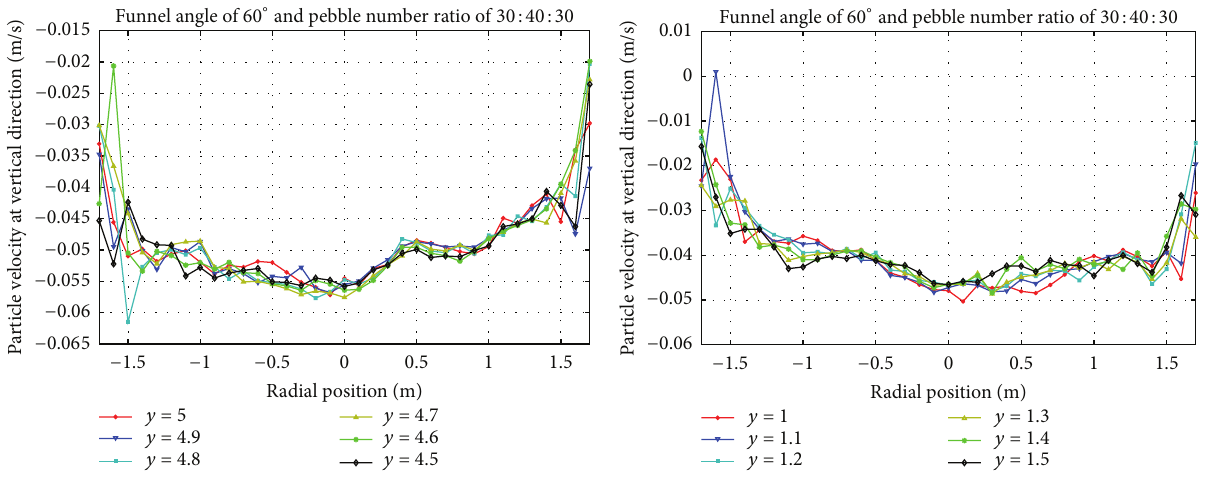
(b) Vertical velocity distribution of pebbles with funnel angel of 60 ∘ at lower region Funnel angle of 60 ∘ and pebble number ratio of 30 : 40 : 30